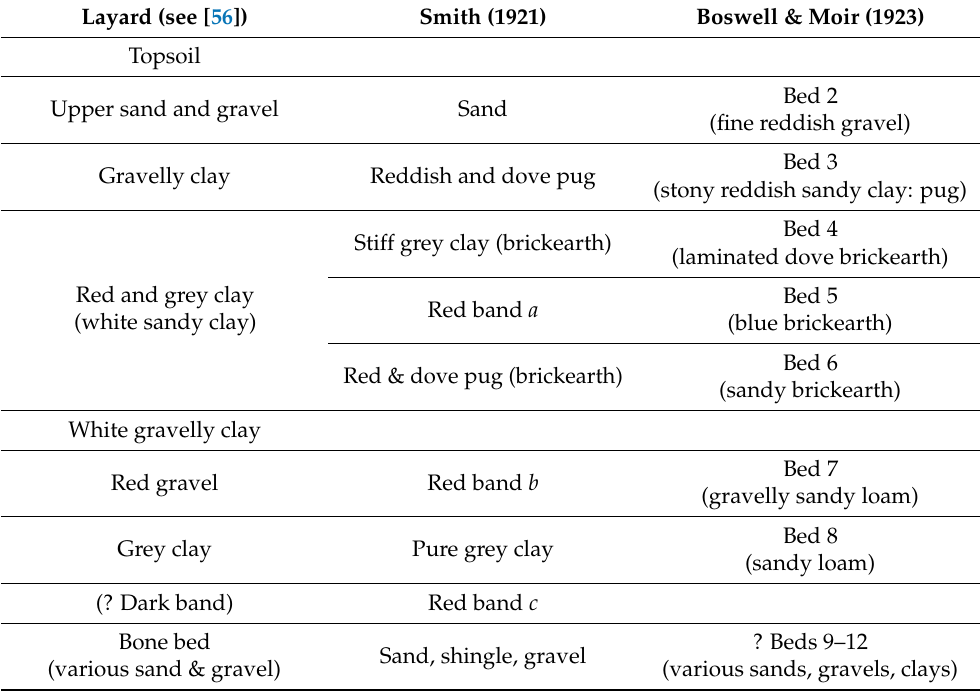
Table 4. The sequence at Foxhall Road, according to different